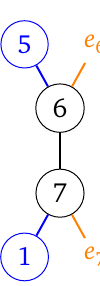
Figure 12: A portion of the cycle from Figure 9 is shown. Tensors 6 and 7 are the focus of this portion, and edges leading away from them towards the rest of the cycle are shown in blue connecting to blue circles (tensors) while those leading out of the cycle are shown in orange.